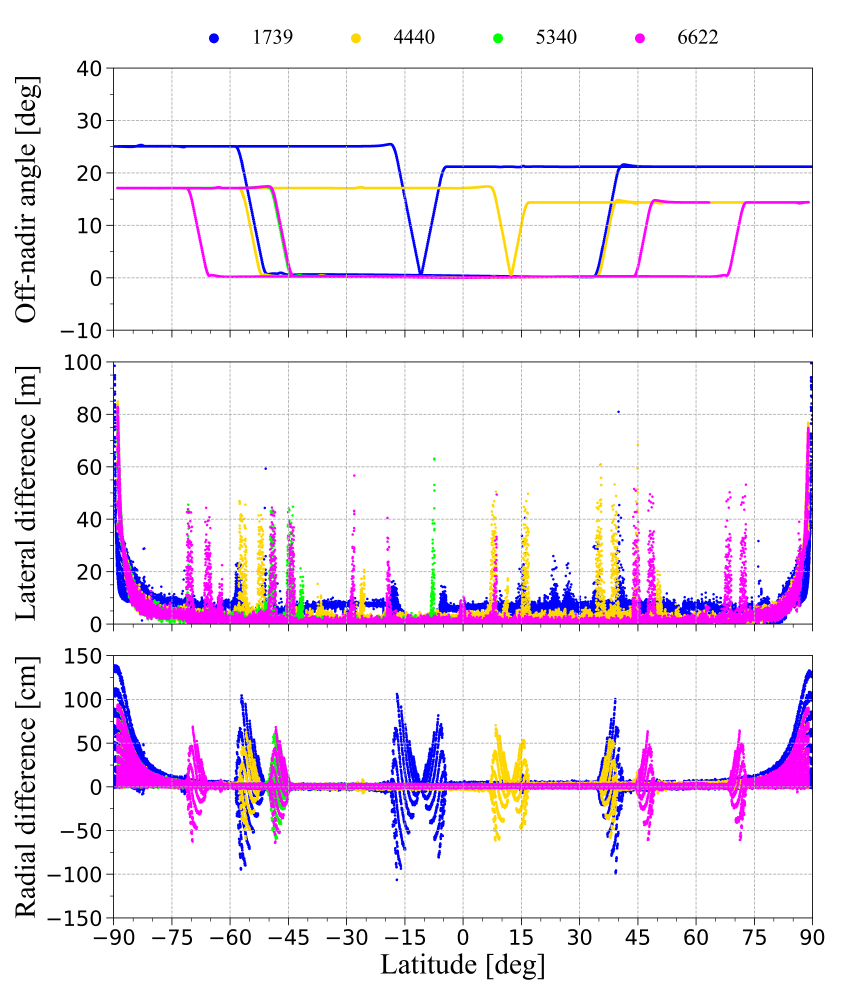
Figure 3. Off-nadir angles of the selected off-nadir profiles ( top ). Lateral ( center ) and radial ( bottom ) residuals of SMM with Mars as the observer with respect to the PEDR for the selected off-nadir pro-